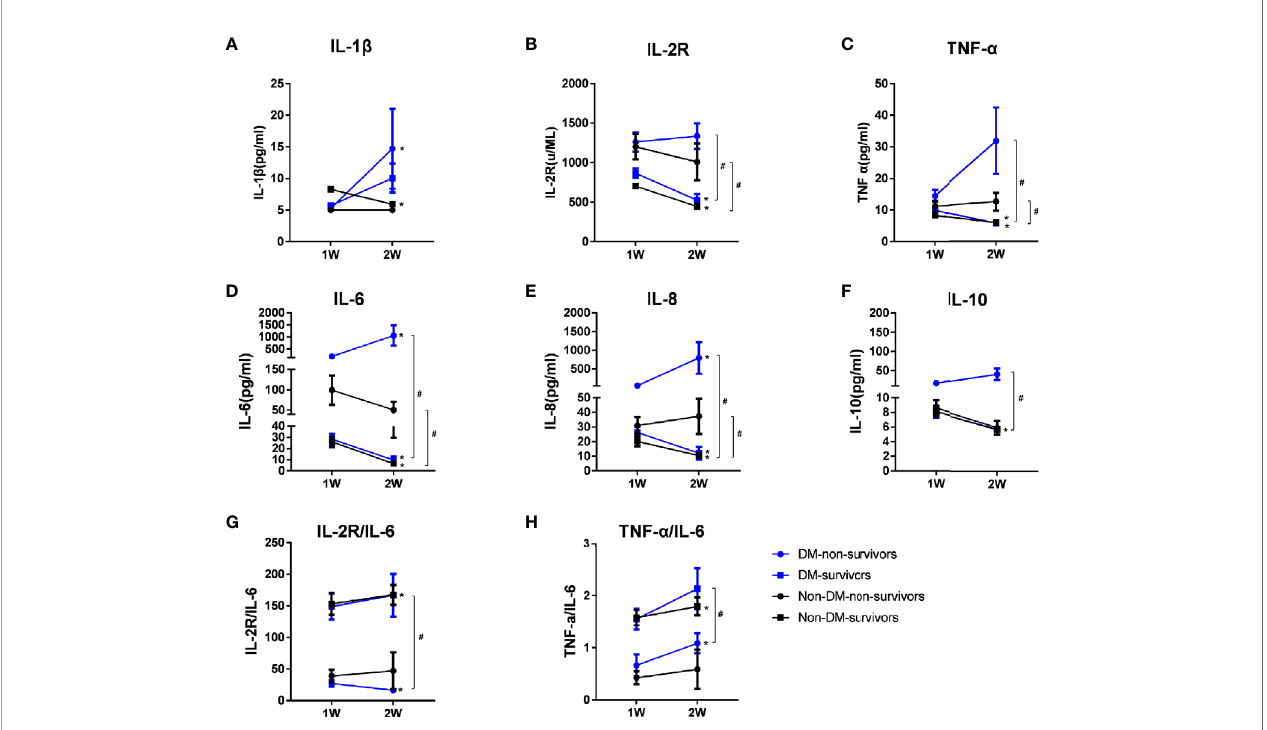
FIGURE 3 | Dynamic changes of serum cytokine levels and Th1/Th2 ratios in groups of diabetic non-survivors, diabetic survivors, non-diabetic non-survivors and non-diabetic survivors from week 1 to week 2. Dynamic changes in Th1 cytokines including IL-1 b (A) , IL-2R (B) , and TNF- a (C) ; Th2 cytokines, including IL-6 (D) , IL-8 (E) , and IL-10 (F) , and ratios of IL-2R/IL-6 (G) and TNF- a /IL-6 (H) representing the Th1/Th2 ratios from week 1 to week 2 after admission in survivors and non- survivors with COVID-19 infection. Data shown are median (IQR). *represents P < 0.05, week 2 vs. week 1. # represents P < 0.05, non-survivors vs. survivors at week 2 in diabetic or non-diabetic patients. DM, diabetes